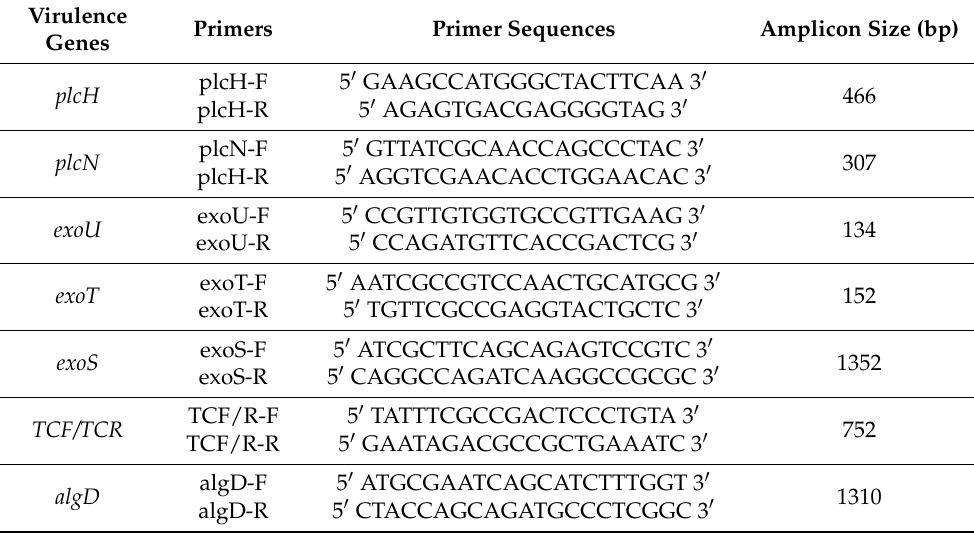
Table 2. Primers for virulence gene